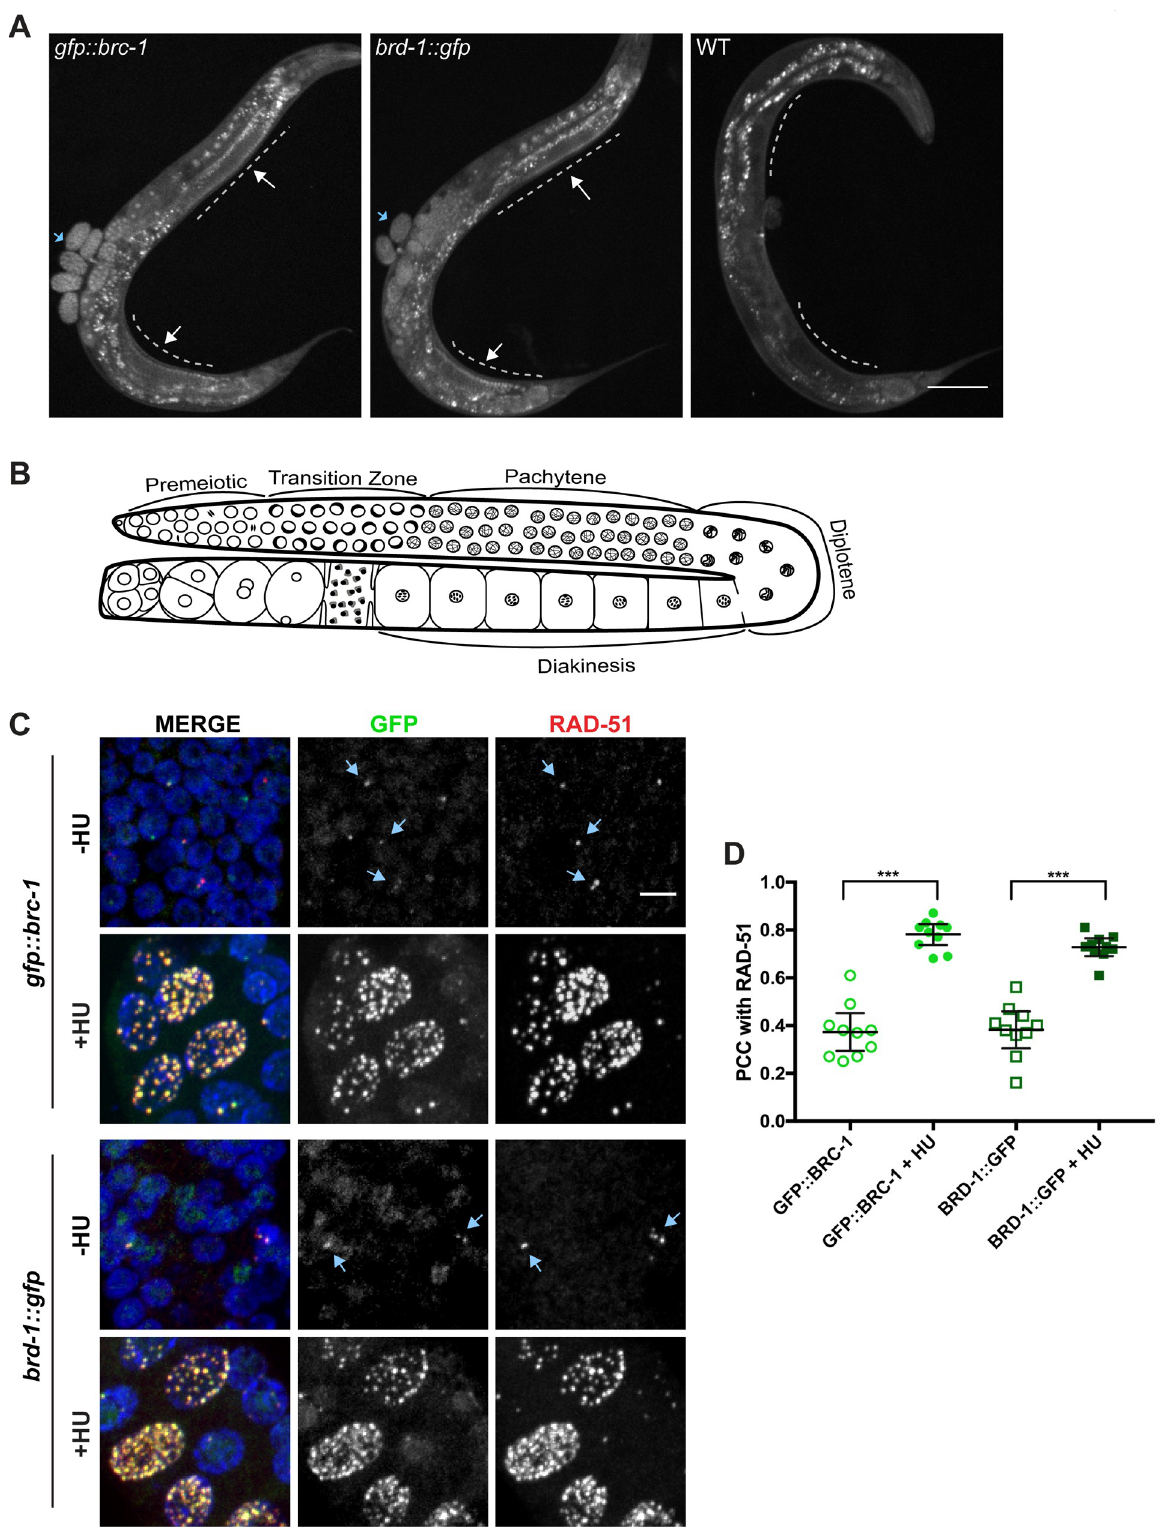
Fig 1. GFP::BRC-1 and BRD-1::GFP are expressed in the germ line and respond to stalled/collapsed replication forks. A) GFP fluorescence of whole worms expressing GFP::BRC-1, BRD-1::GFP, or no GFP (WT). Dashed line denotes germ line with arrows to indicate GFP fluorescence;